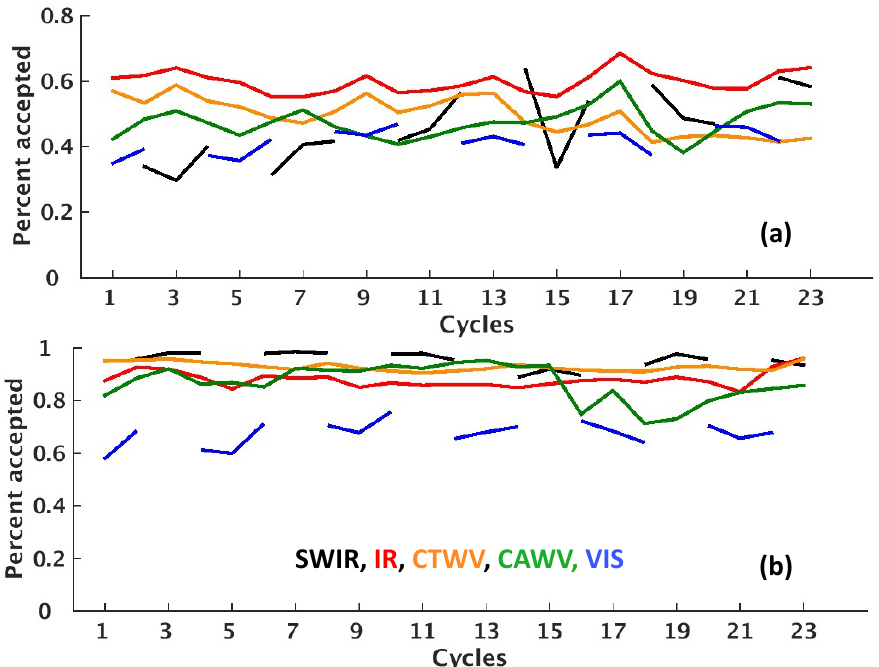
Figure 5. Percentage of observations assimilated in HWRF ghost d02 domain for each AMV type per cycle ( a ) with QI > 80% and PCT1 < 0.04 check and ( b ) without QI > 80% and PCT1 < 0.04 check for Hurricane Michael.